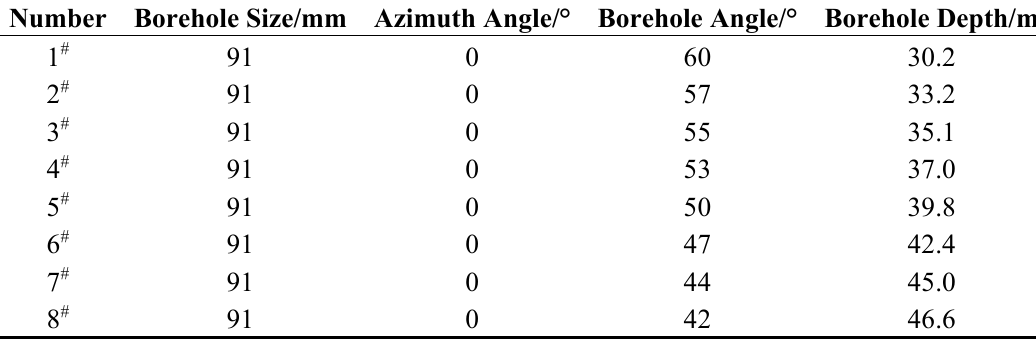
Figure 4. The layout of the fracturing boreholes: ( a ) the plan of the fracturing boreholes; ( b ) the section of the fracturing boreholes. Table 1. Fracturing boreholes